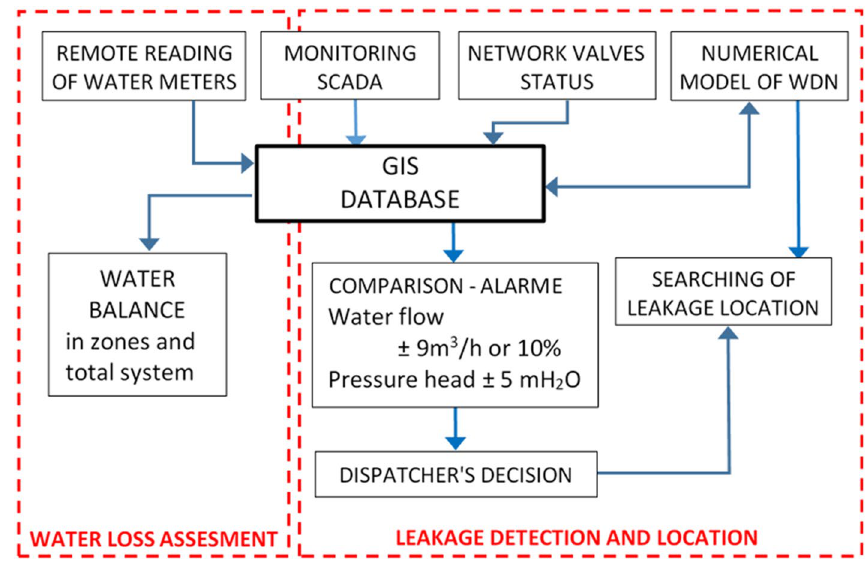
Fig. 3 Schematic diagram of the proposed diagnostics